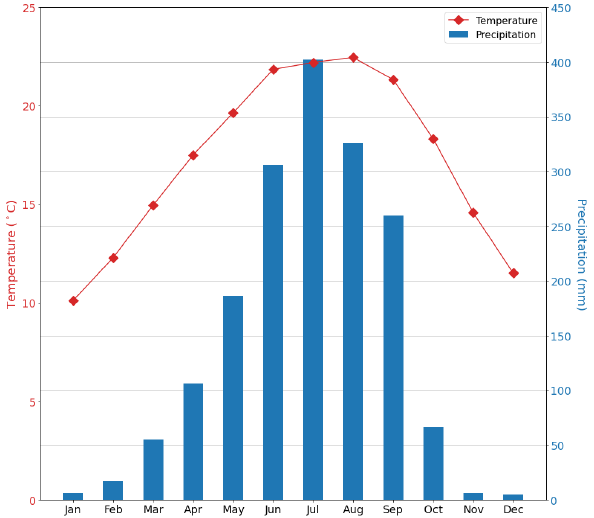
Figure 2. The climatology of Bhutan based on measurements from the 20 weather stations managed by the Bhutan Hydrological department. Temperature refers to average monthly surface air tempera- ture (°C) and precipitation is the mean monthly total precipitation (mm). It is based on the period covered by the weather station records from 2012 to